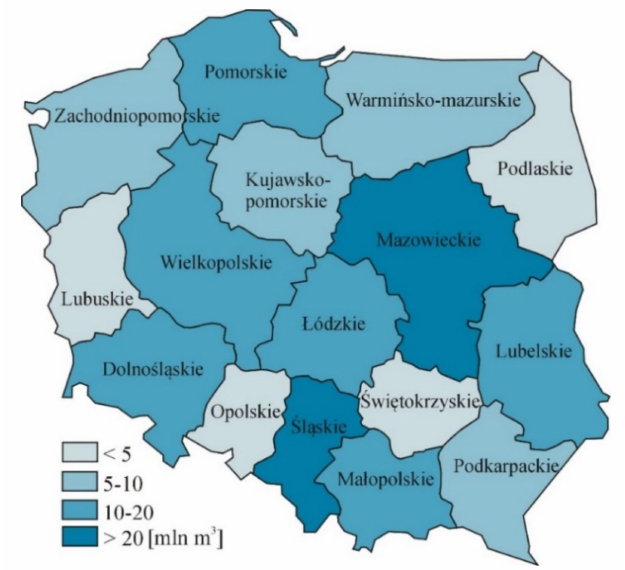
Figure 11. Volume of BM that can be obtained for municipal waste in Poland (mln m 3 /year).